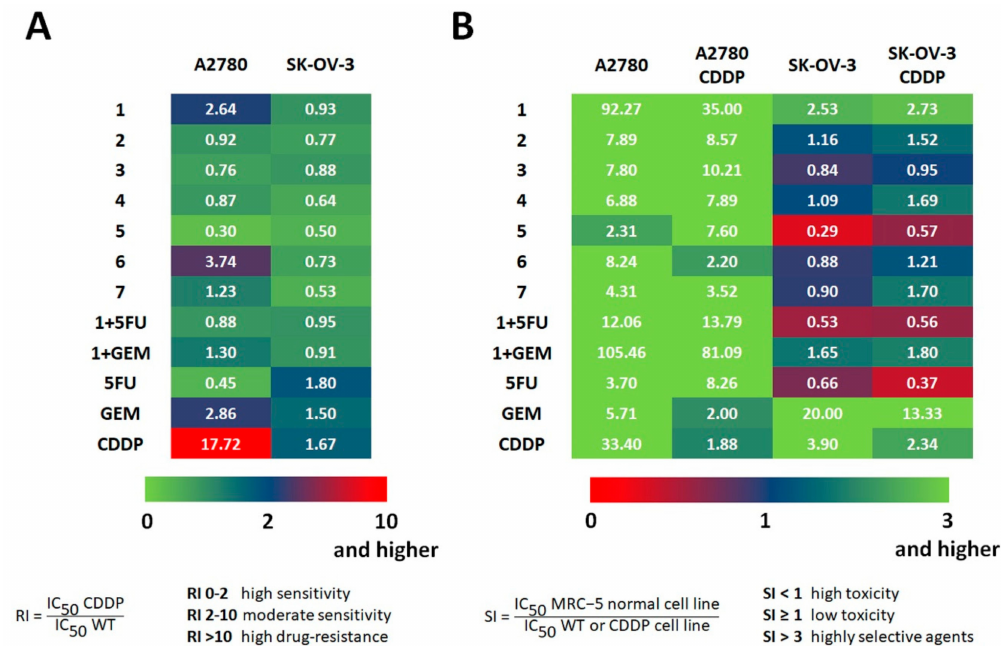
Figure 3. Calculated values of ( A ) the resistance indexes (RI), and ( B ) selectivity indexes (SI) of the tested